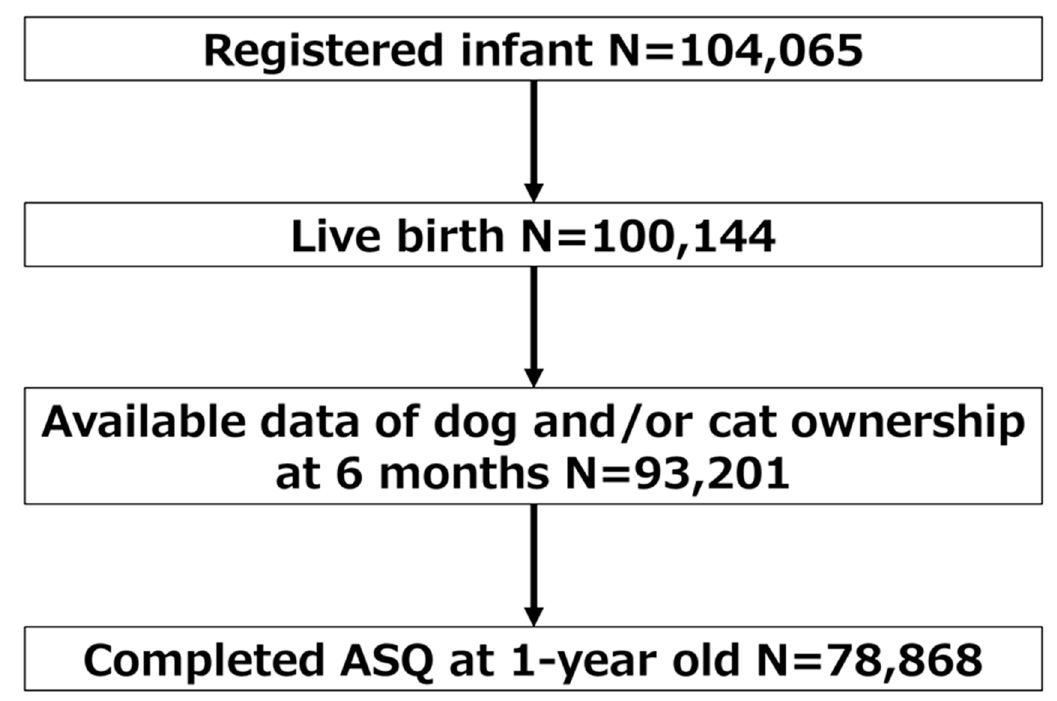
Figure 1. Selection of study population.